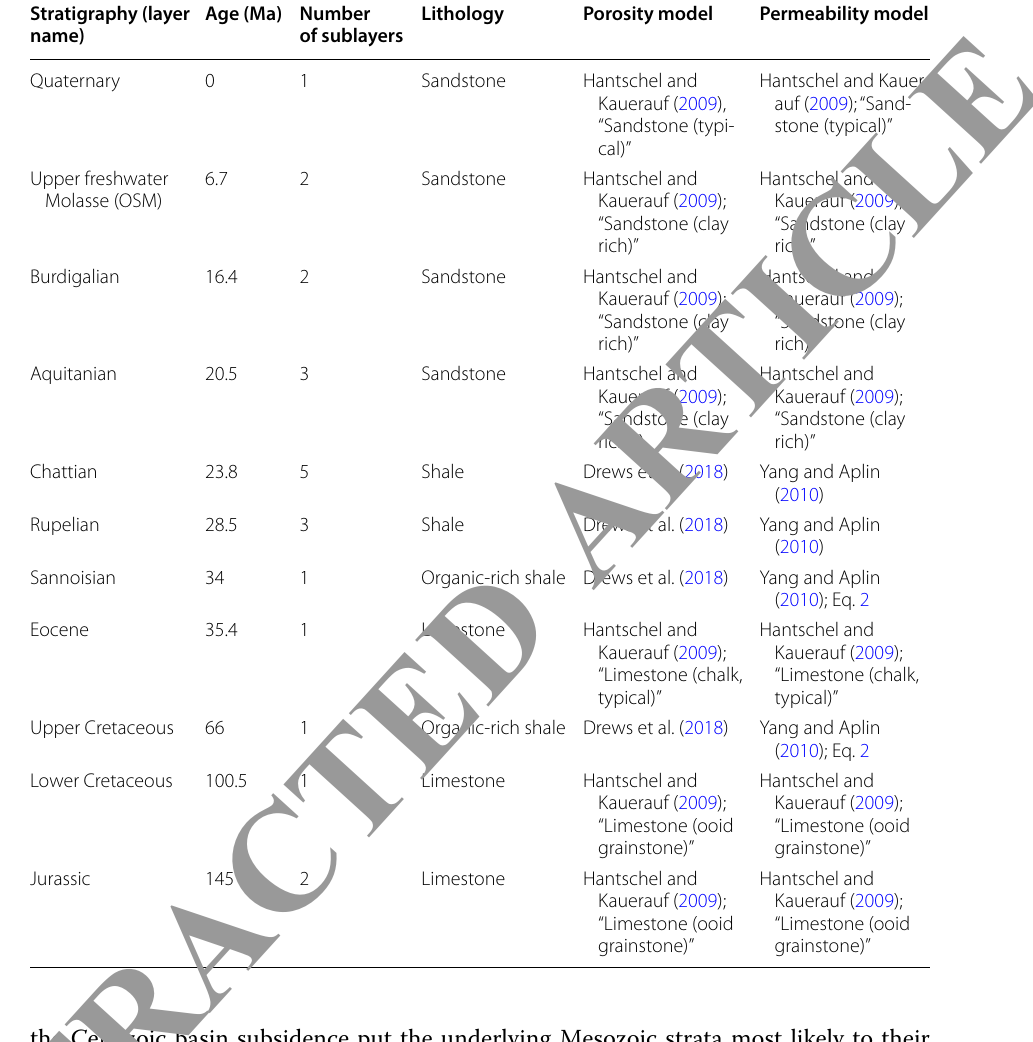
Table 3 Age, lithology, porosity and permeability models for stratigraphic units used in the 3D basin model Stratigraphy (layer